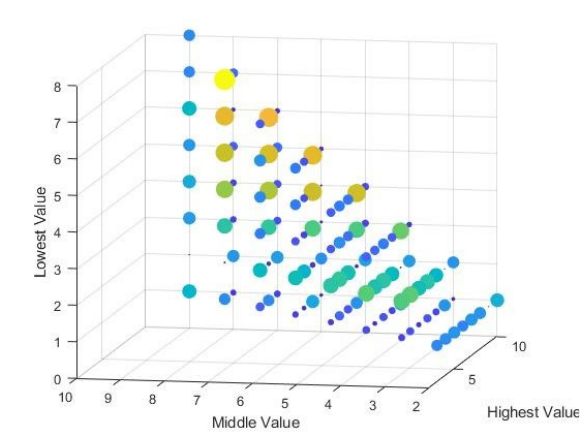
Figure 6: RMS value of base dataset